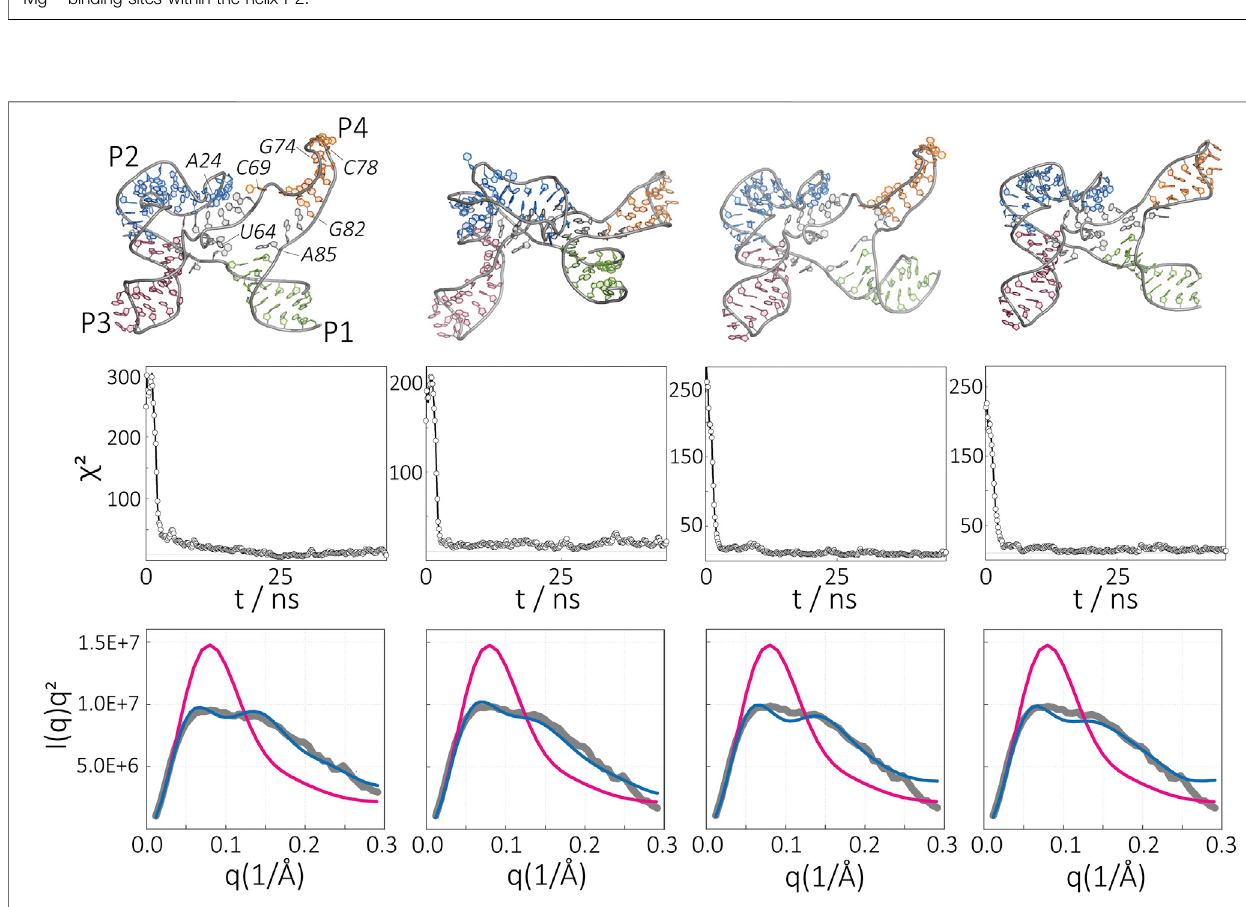
FIGURE 7 | Apo-state of the SAM-I riboswitch aptamer in the absence of Mg 2+ . Ensembles of conformations obtained by SAXS-driven MD simulations. The fi nal structures (top), time evolution of χ 2 (middle), and resultant Kratky plots (bottom) are given for four independent simulations. The intensity of the structure before (magenta) and after (blue) the SAXS-driven MD in comparison to the experimental data (gray).